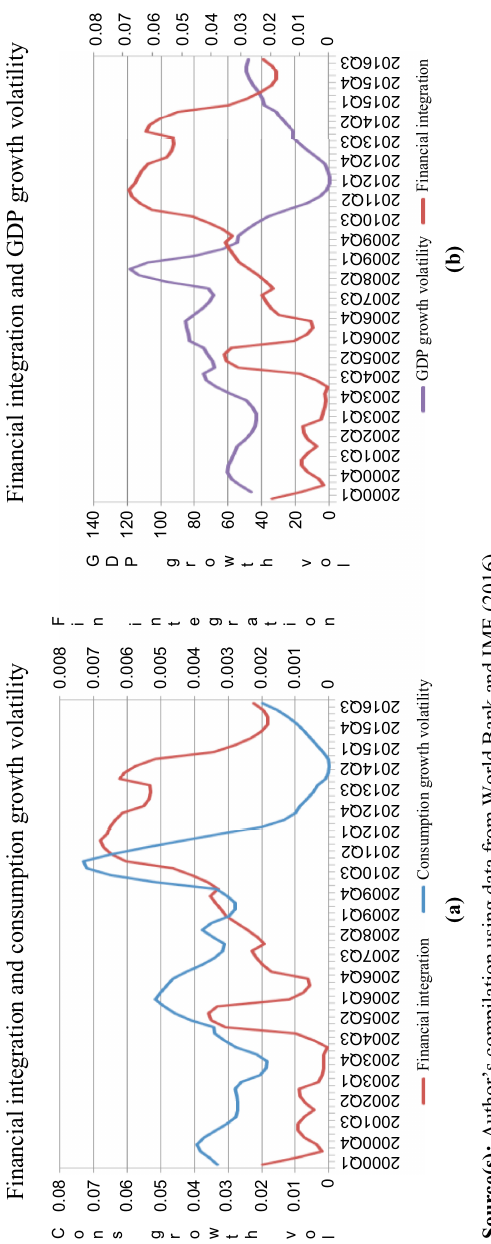
Figure 3. Trends of macroeconomic volatility and financial